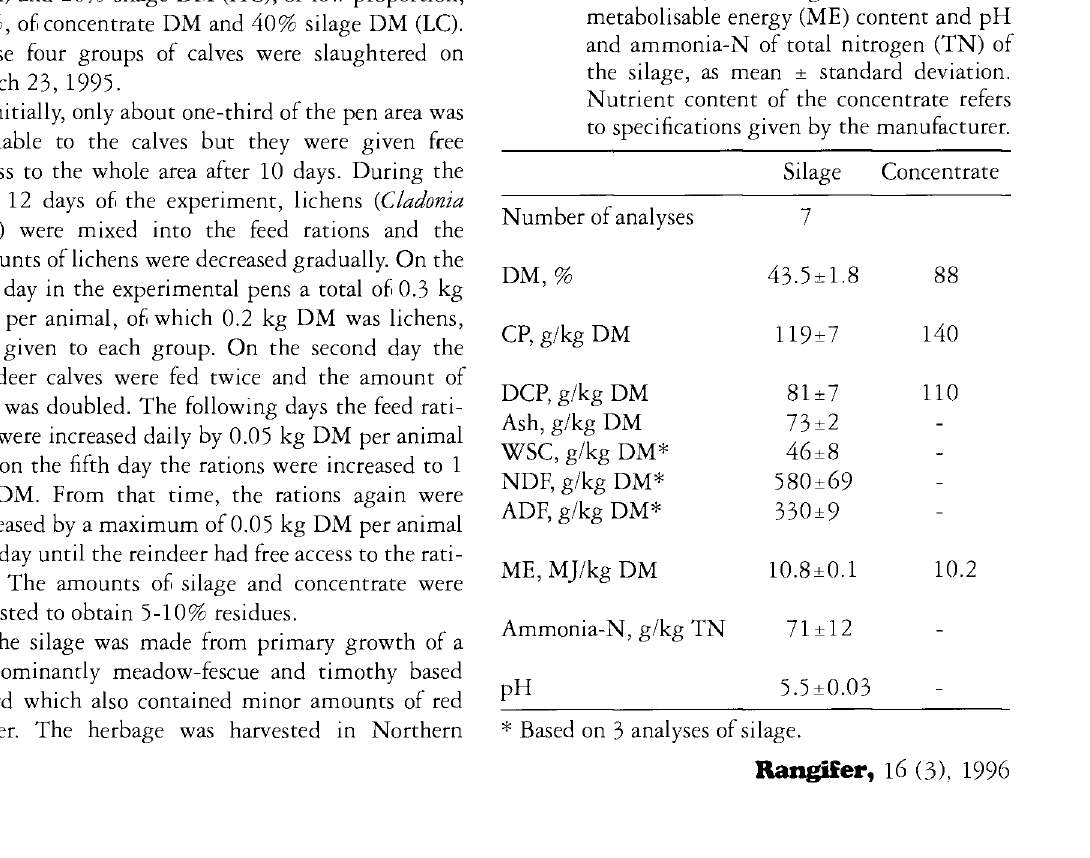
Table 1. Dry matter (DM), crude protein (CP), digestible CP (DCP), ash, water soluble carbohydrates (WSC), neutral detergent fibre (NDF), acid detergent fibre (ADF) and metabolisable energy (ME) content and pH and ammonia-N of total nitrogen (TN)